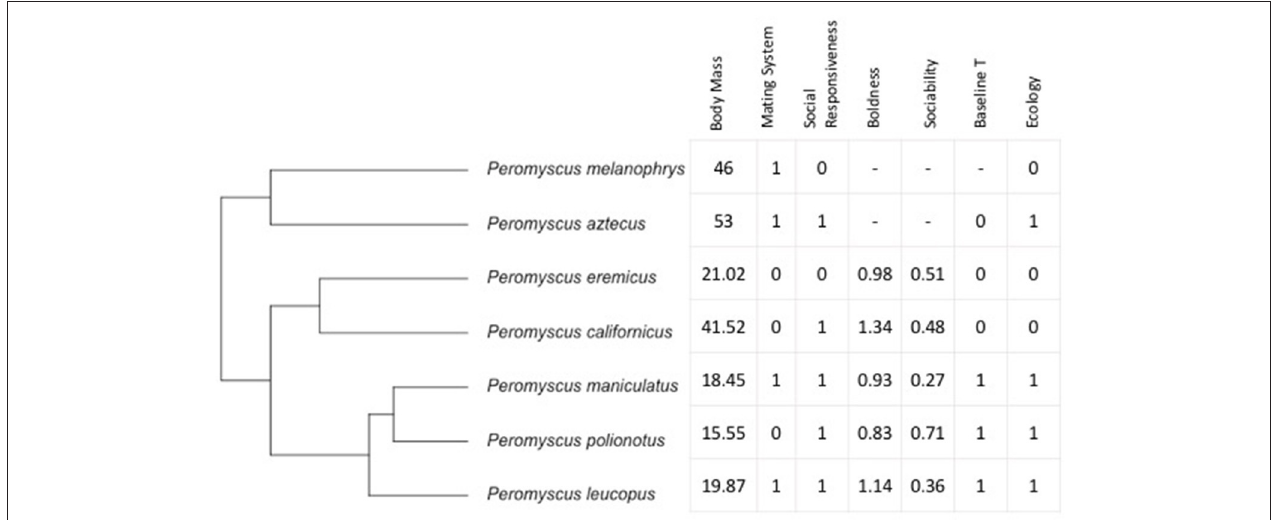
FIGURE 1 | Topology used for phylogenetic analyses (derived from Bedford and Hoekstra, 2015) with predictor variables shown for each species for which there was data available. Body Mass (g); Mating System: 0, predicted monogamous, 1, predicted non-monogamous; Social Responsiveness: 0, testes do not respond to presence of a female, 1, testes do respond to presence of a female; Boldness: unitless measure of latency to exit; Sociability: unitless measure of time spent with same sex stimulus; Baseline T: 0, low, 1, high; Ecology: 0, xeric, 1, mesic. Refer to text for sources of